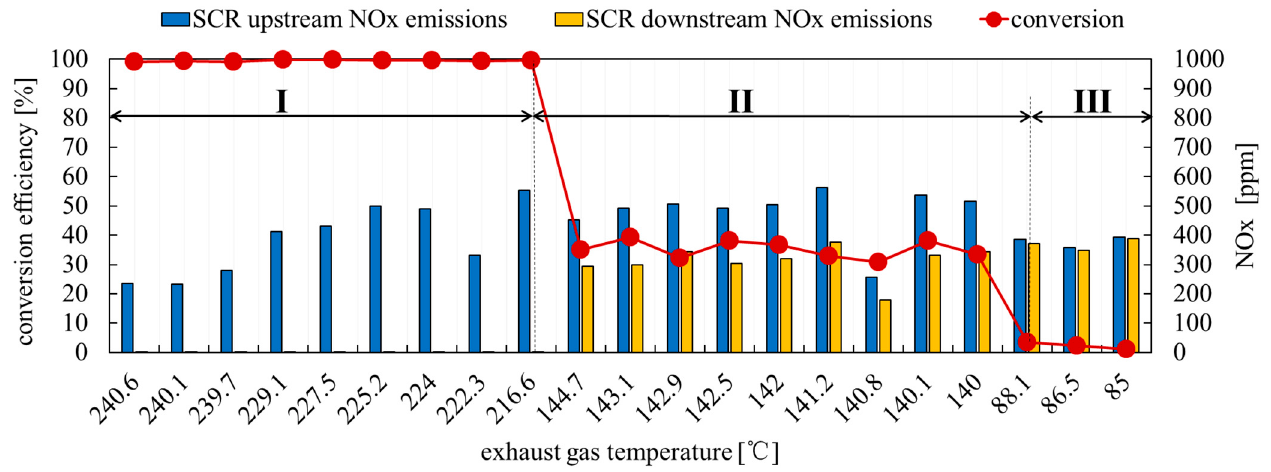
Figure 7. Effect of exhaust temperature on conversion efficiency.